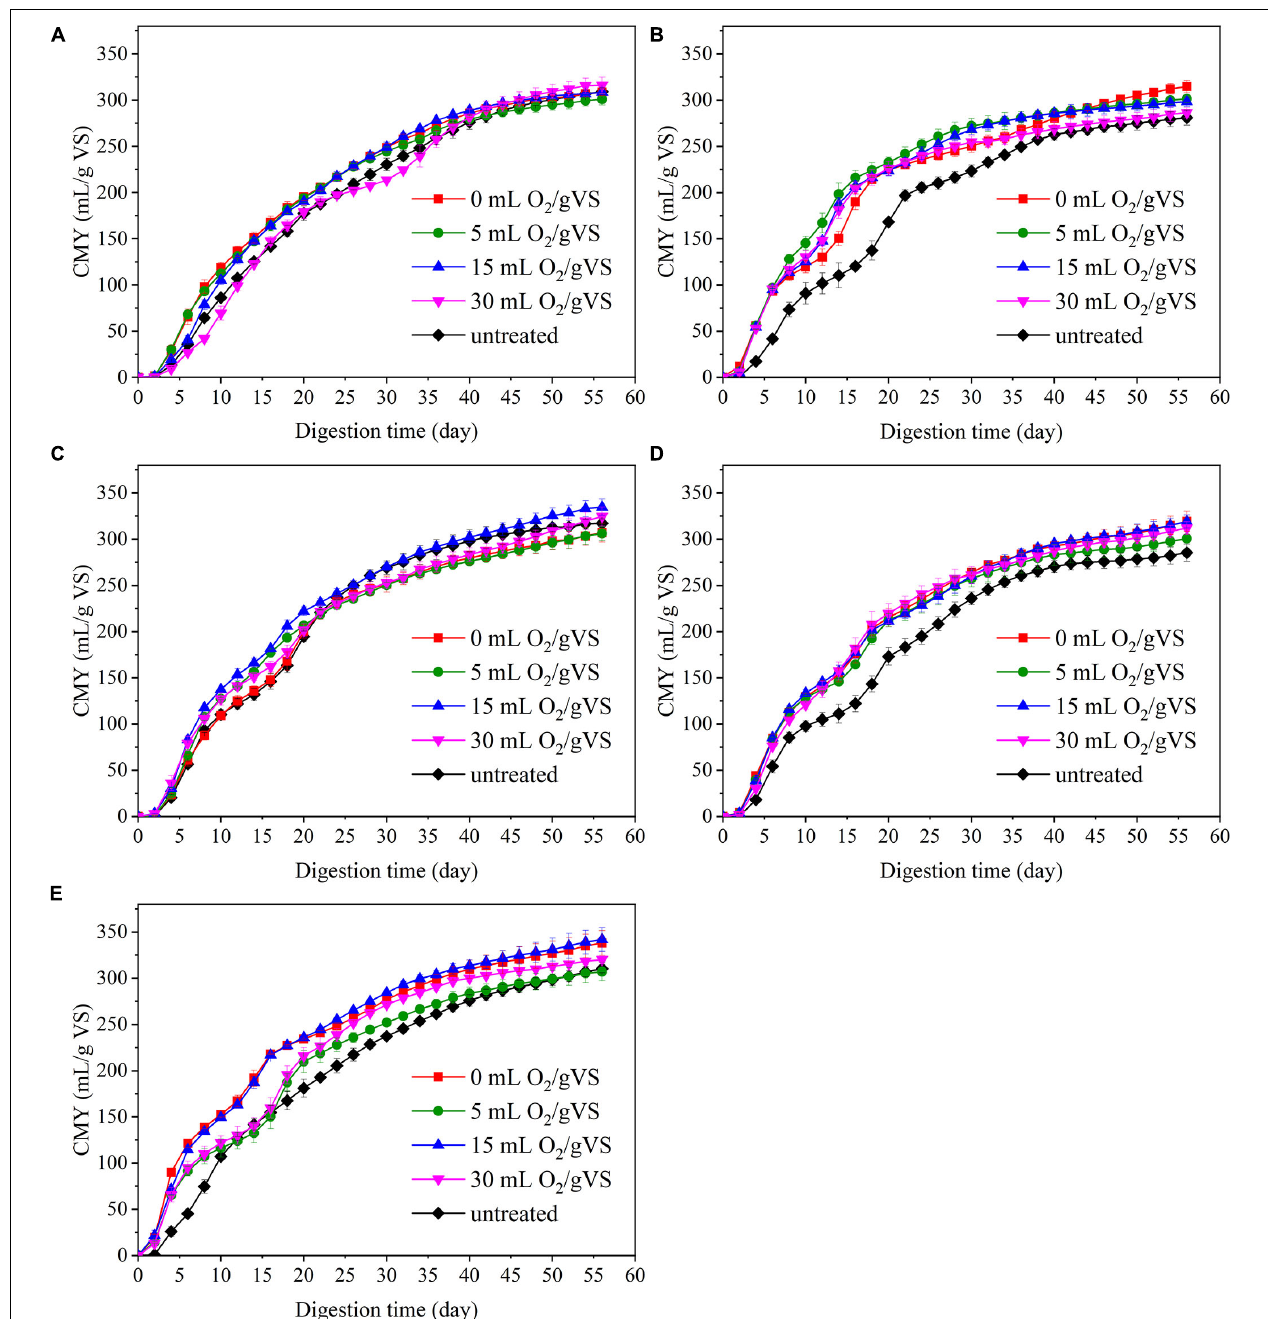
FIGURE 4 | The cumulative methane yield (CMY) of untreated and pretreated PW by CI (A) , SI (B) , CM (C) , SM (D) , and DE (E).